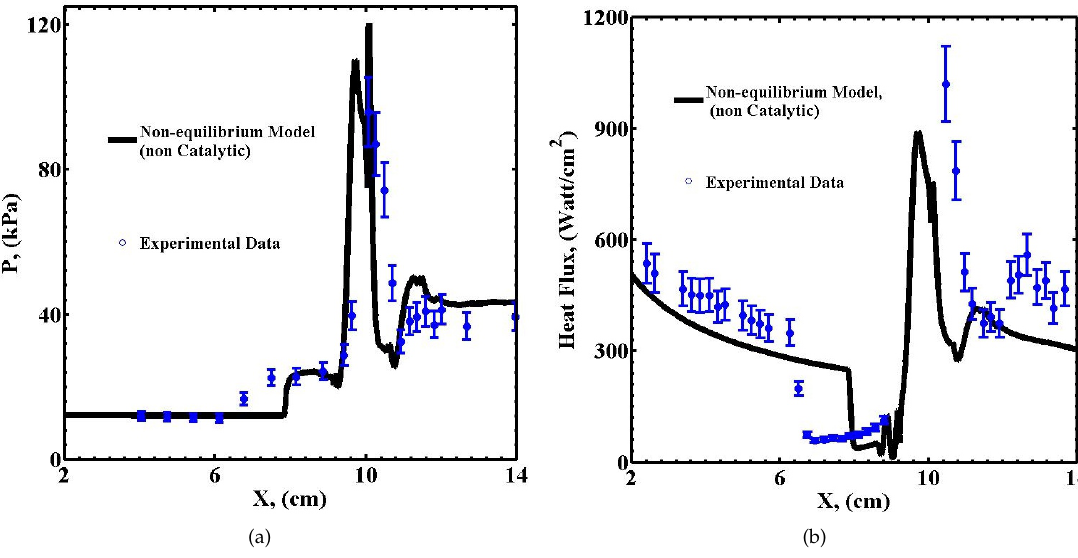
Figure 9. Computational results for Run 6, Table 1, using the non-equilibrium Navier–Stokes model. ( a ) Surface pressure; ( b ) Heat transfer rate.